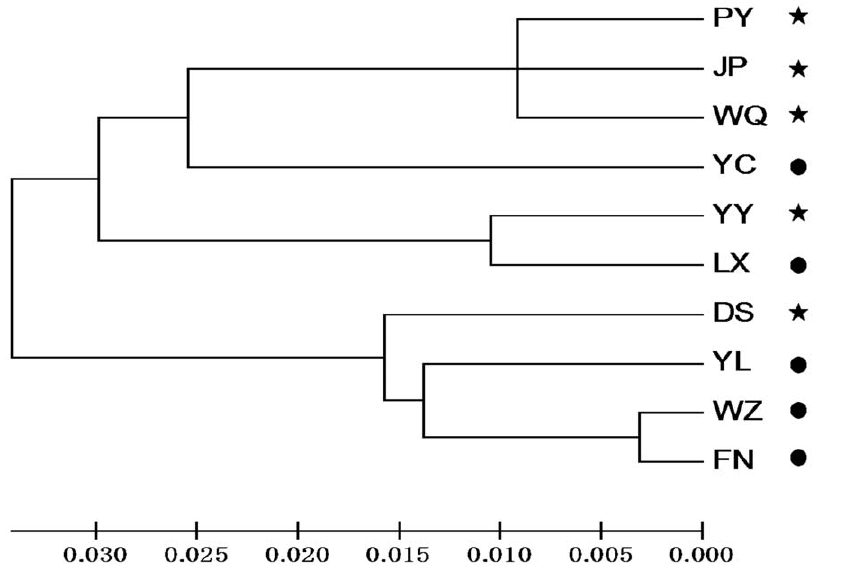
Figure 2. Neighbor-joining phenogram of Nei’s genetic distances between H.hippophaecolus populations at different collection sites. Site names and outbreak patterns correspond to those in figure 1. Populations are depicted as outbreaking (star) or non-outbreaking (circle).